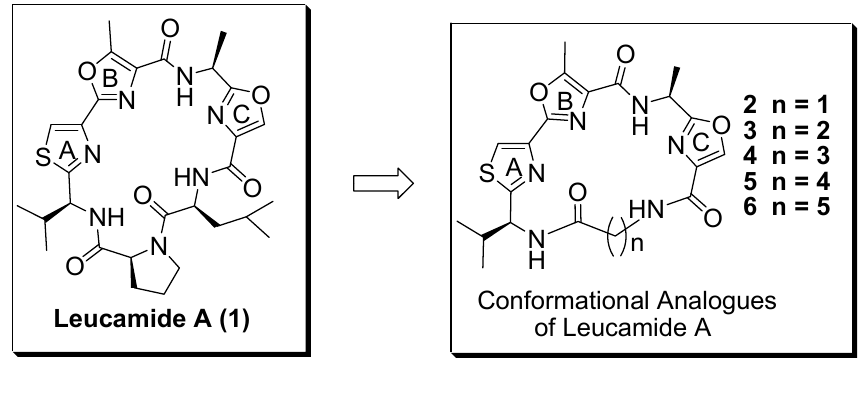
Figure 1. Leucamide A and its conformational